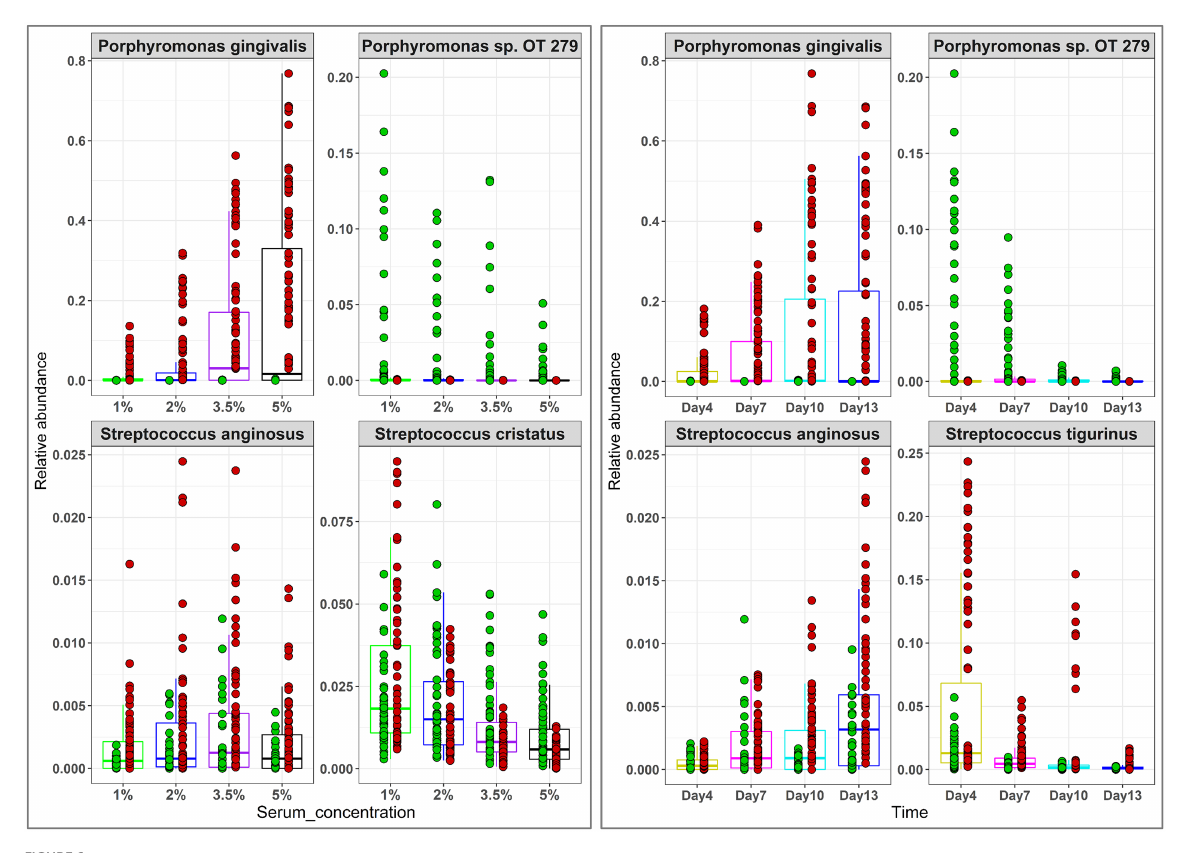
FIGURE 6 Selected differentially abundant species by serum concentration and incubation period. Centered log-ratio (CLR) transformed data were analyzed with MaAsLin2 including health status, biological replicate, medium, shaking, and incubation time as fixed effects and technical replicates as random effects. Relative abundances are shown for 4 pairs of ‘sister” species that significantly differed (FDR value < 0.1) between the two groups. Plots were produced with